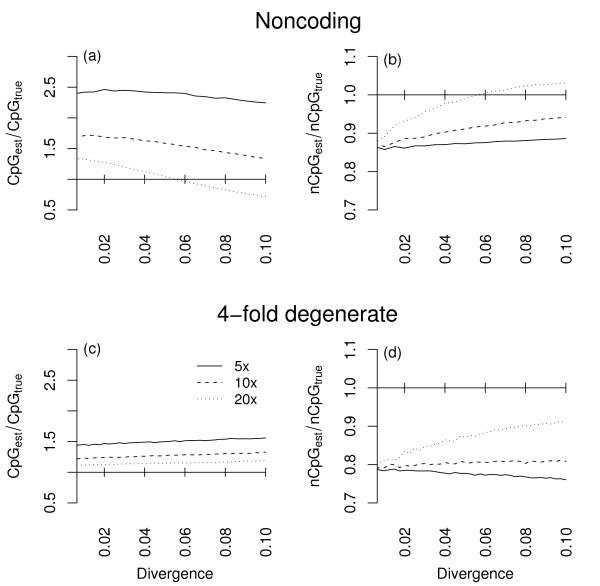
Substitution rates in phylogenies derived from real sequence data. Ratio of estimated (CpGest) to true (CpGtrue) CpG differences and estimated (nCpGest) to true (nCpGtrue) non-CpG differences plotted against increasing sequence divergence for phylogenies derived from real mouse noncoding (a, b) and coding (c, d) sequences. Separate lines show results for different levels of hypermutability (5-fold, 10-fold and 20-fold hypermutability). Each line is composed of is estimated from 80 simulated replicates of an ~8 Mb sequence.